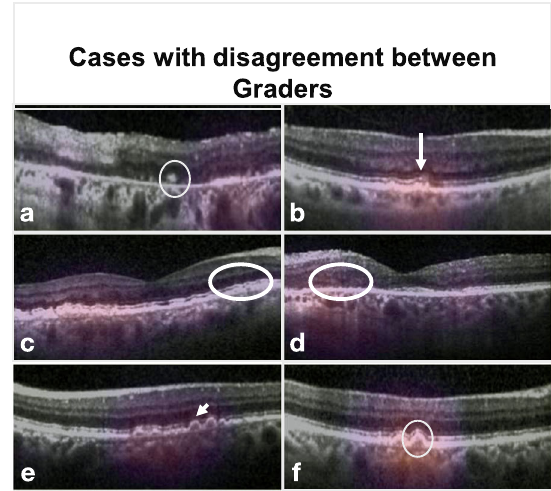
Fig. 4 Examples of discordant cases. B-scans of example cases where SLIVER-net ’ s determination disagreed with the expert human graders, with heat map overlay highlighting the most informative regions of the image as determined by the algorithm. Panels a – c show examples of false-negative cases where the feature was detected by the grader on initial review, but not by the algorithm. In a , b , virtually no separation can be seen between retinal pigment epithelial (RPE) band and the drusen, which presumably made it dif fi cult for the algorithm to determine that these were intraretinal hyperre fl ective foci (IHRF). In fact, on post hoc review, the senior retina specialist sided with the algorithm. In c , the heat map highlights the relevant features, but the algorithm failed to identify these tiny conical or spike-like elevations as subretinal drusenoid deposits (SDD). This was deemed to be a true false negative on post hoc review, yet it should be noted that no clear distinction in re fl ectivity is observed between the SDD and the underlying RPE. Panels d – f show examples of false positives where the algorithm detected a biomarker but the ground-truth human grader did not on initial review. In d , the heat map highlights a drusen but there are no apparent IHRF. However, there are occasional tiny bright dots in the Henle ’ s layer which are due to retinal capillaries but may have been confused as IHRF. This is a true false positive. In e , the algorithm detected a drusen with hypore fl ective core (hDC), but the drusen was small and <40 µm in height. By de fi nition, graders do not assess the internal re fl ectivity in lesions this small. The algorithm was able to make this assessment and the internal re fl ectivity is a bit reduced, but it is a true false positive as it does not match the grading convention. In f , the algorithm also determined hDC to be present, but the internal re fl ectivity of the drusen, while reduced, is not dark enough to be called hypore fl ective. This is also a true false positive.